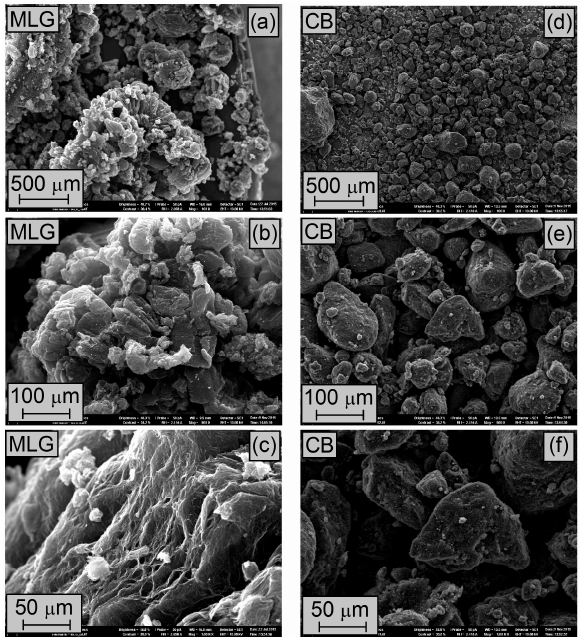
Figure 1. SEM micrographs of ( a – c ) MLG and ( d – f ) CB.